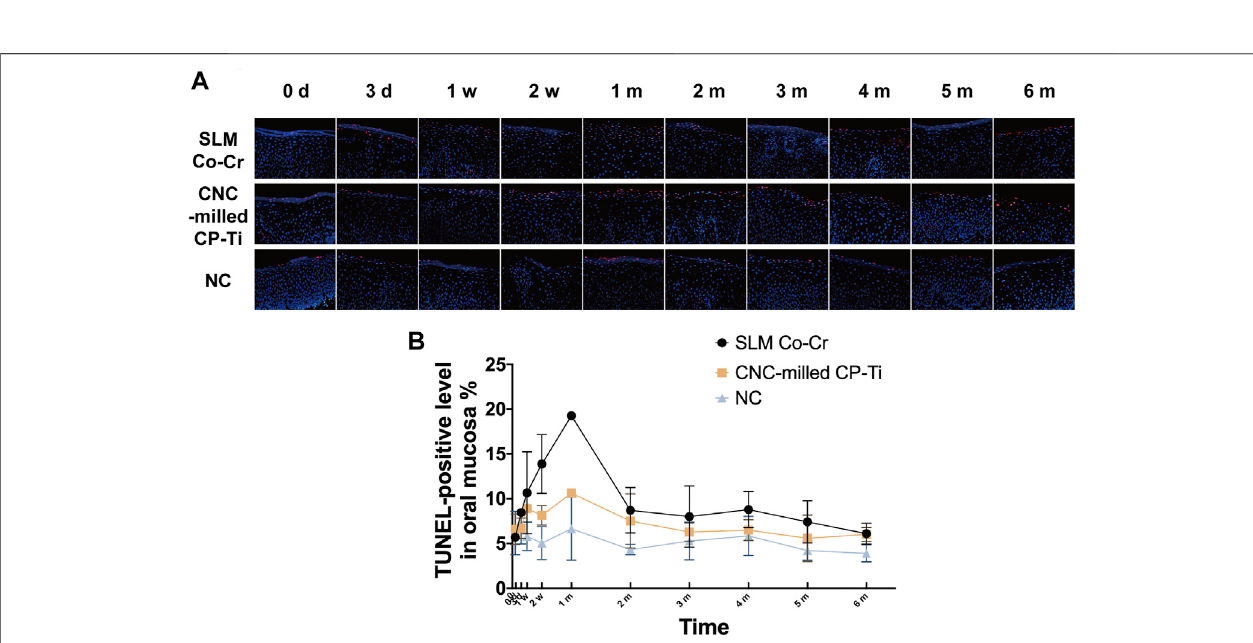
FIGURE4| Representativeimagesandquanti fi cationofTUNELpositivityintheoralmucosaaffectedbySLMCo-CralloysandCNC-milledCP-Ti.Panelsshow (A) representativeTUNEL+labelingofdouble-strandedDNAintheoralmucosawithredstaining, (B) quanti fi cationofTUNEL+labelingasperformed(originalmagni fi cation 400 × ).Therewasastatisticallysigni fi